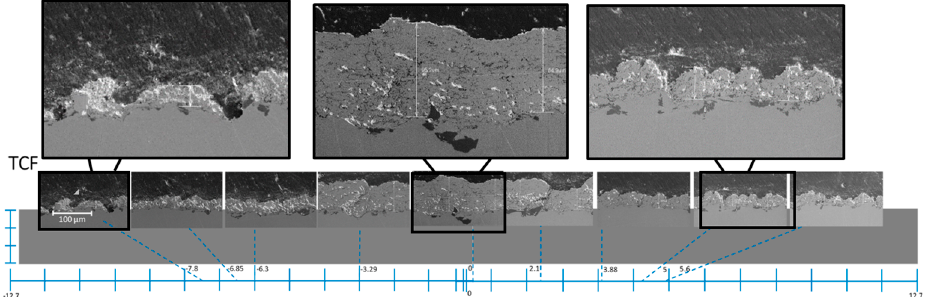
Figure 18. Cross-section images showing the structures developed in the flat coarse grit-blasted sample